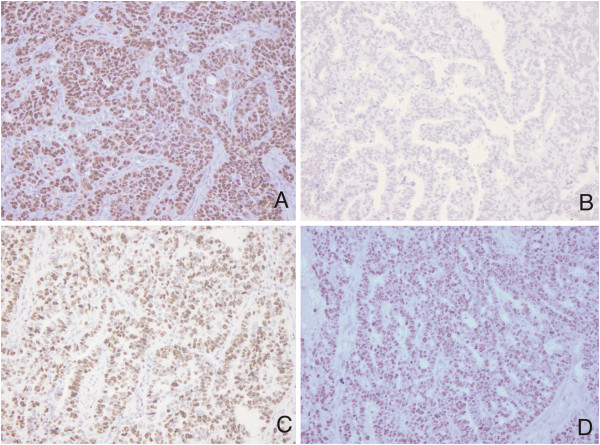
Representative immunostaining patterns of high-grade OSCs. Strong p53 immunoexpression (A; original magnification, × 200), negative MAPK immunoexpression (B; original magnification, × 200), positive topoII alpha immunoexpression (C; original magnification, × 200), high Ki67 proliferative activity (D; original magnification, × 200).